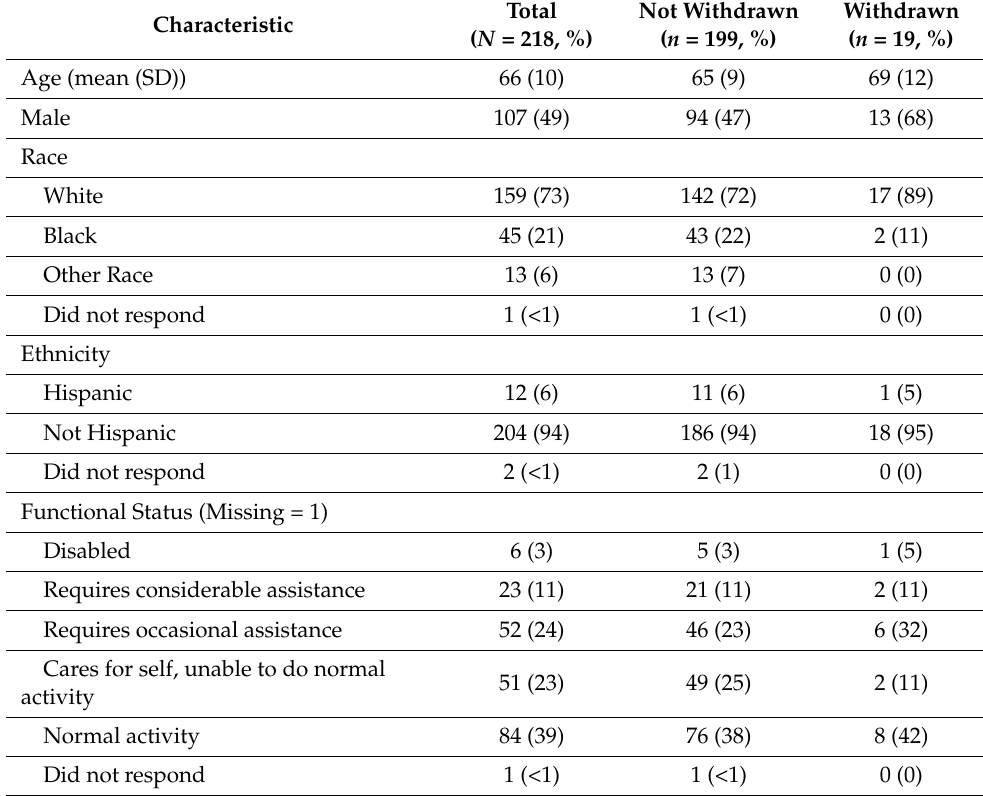
Table 1. Characteristics of study participants, showing the distribution among those that withdrew and did not withdraw from the program ( N =